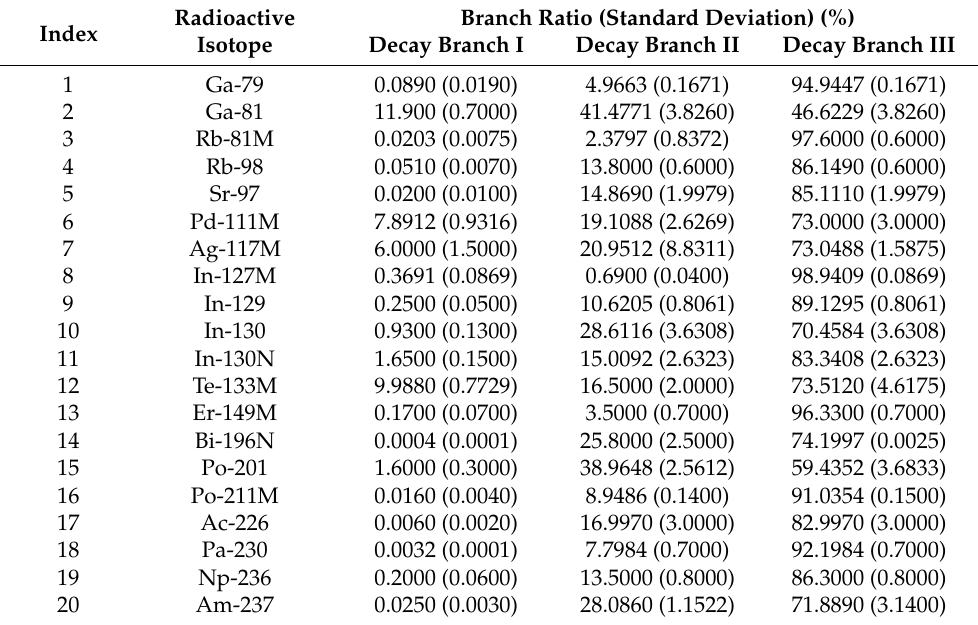
Table 1. Branch ratio data of selected radioactive isotopes from